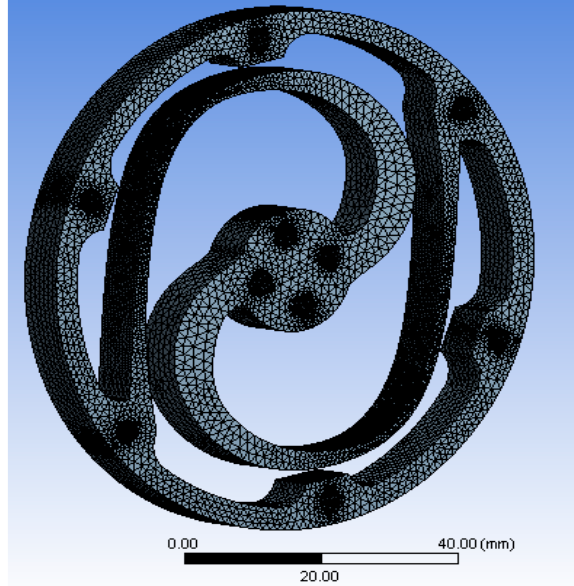
Figure 7. Meshed module. Figure 7. Meshed Table 4. Number of nodes produced for finite elements design.